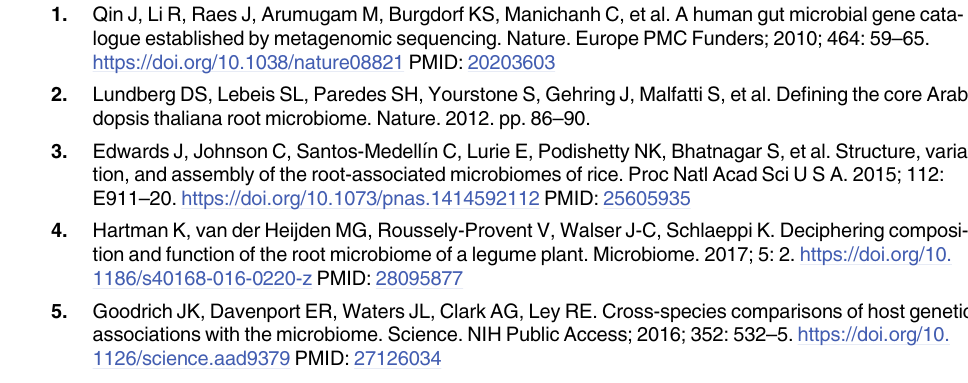
S1 Table. Dominant cultivated bacteria and dominating OTUs in five root vegetables. Top three dominant cultivated bacteria in each vegetable sample based on MALDI-TOF mass spec- trometry identification and top three dominating OTUs from the same samples indicated